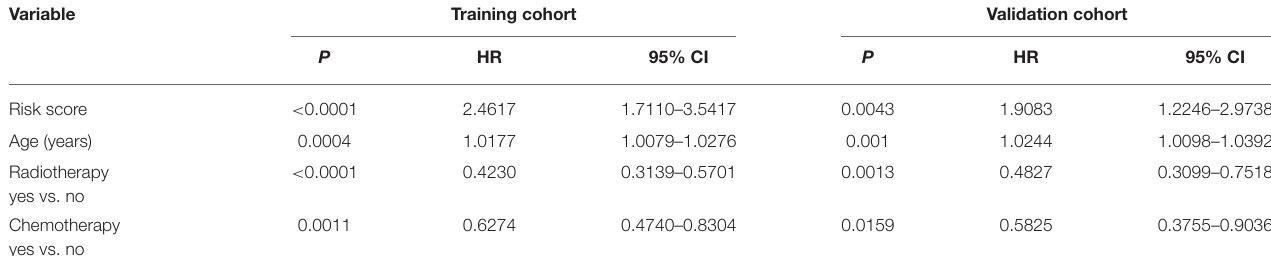
TABLE 2 | Multivariate analysis of the training cohort and validation cohort for overall survival.